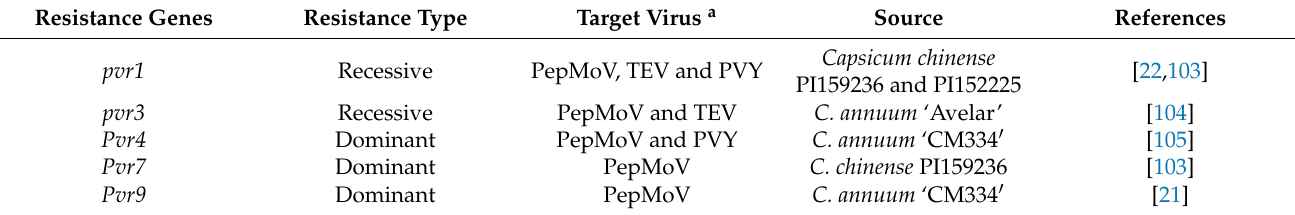
Table 1. Reported resistance genes against